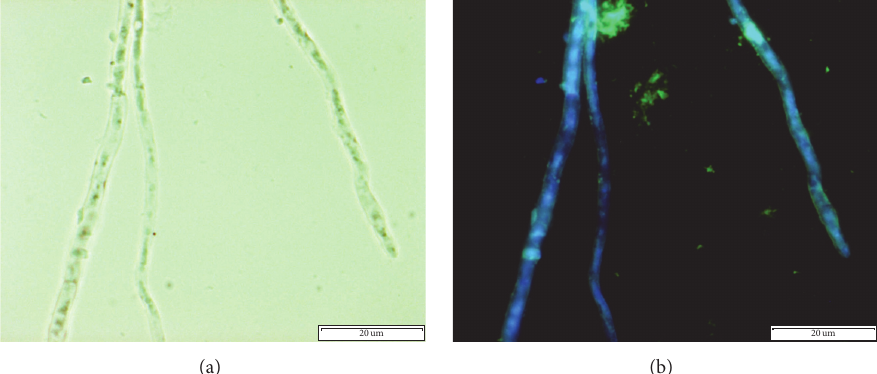
Figure 1: Detection of (1 → 3)- 𝛼 -d-glucan in the hyphae of C. unicolor strain C-139 by means of fluorophore-labelled antibodies (Clone IgM MOPC-104E). (a) Filaments in the light microscopy, (b) fluorescent image of the same filaments. Twenty samples were observed and typical images are presented. Scale bar = 20 𝜇 m.